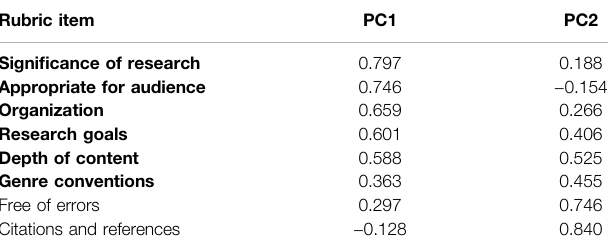
TABLE 3 | Component weights from the Principal Component Analysis after Varimax rotation with Kaiser normalization for all eight rubric items for both SciWrite and non-SciWrite proposals. Rubric items addressing higher-order concerns are in bold, and the order is determined by the fi rst principal component (PC1)weights.The fi rsttwoprincipalcomponentsarepresentedbecauseonly their eigenvalues were > 1. Rubric item PC1 PC2 Signi fi cance of